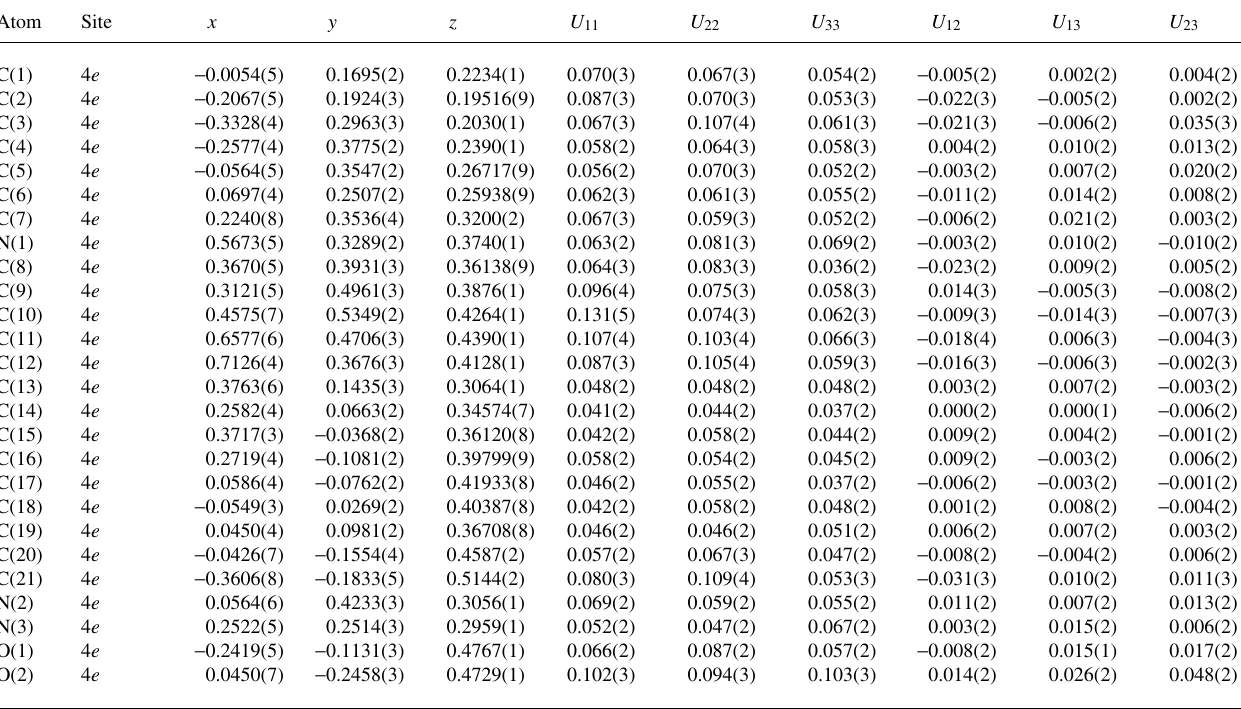
Table 3. Atomic coordinates and displacement parameters (in Å 2 )